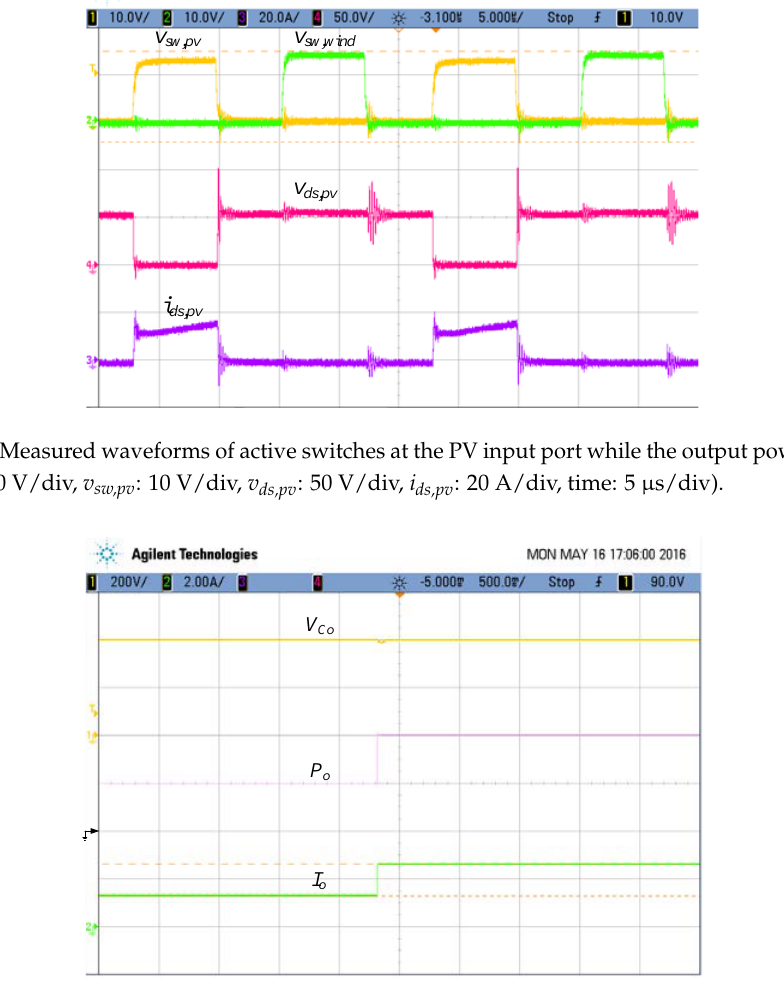
Figure 11. Measured waveforms to illustrate the transient response of the DIPWC ( v sw,wind : 10 V/div, v sw,pv : 10 V/div, v Lo : 200 V/div, i Lo : 2 A/div, time: 5 μs/div).